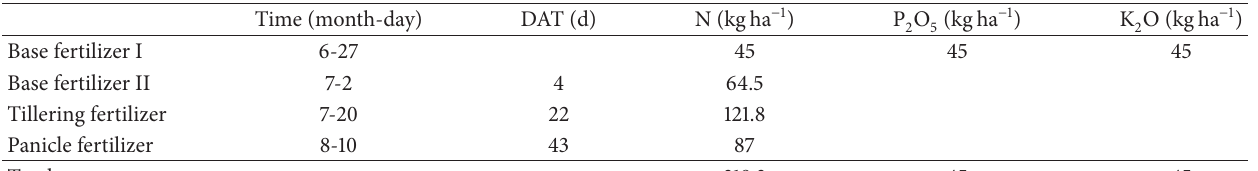
Table 1: Time and amount of fertilization.